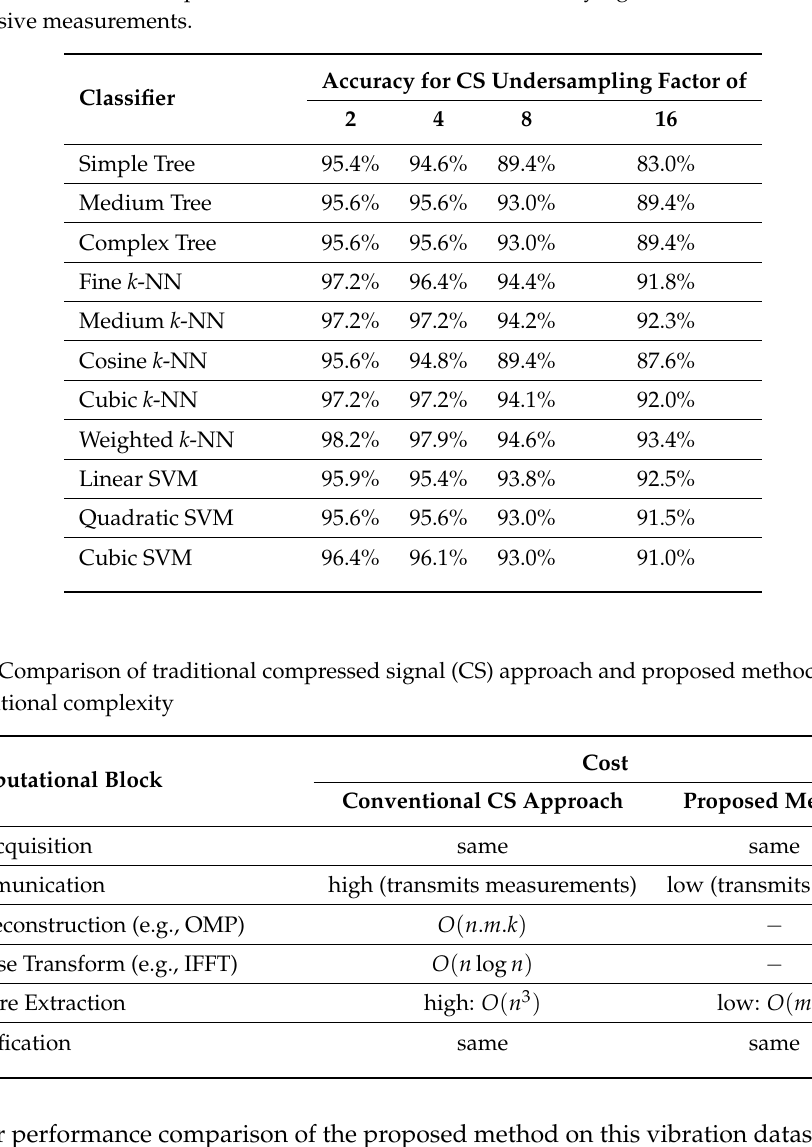
Table 3. Performance comparison of different classifiers in classifying the features extracted from compressive measurements.